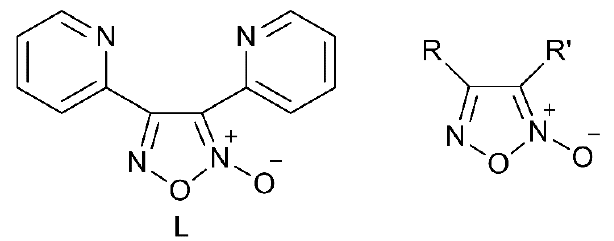
Figure 2. The ligand di(2-pyridyl)furoxan that is present in complex 1 and the general structural formula of furoxans(derivatives of 1,2,5-oxadiazole-2-oxide).